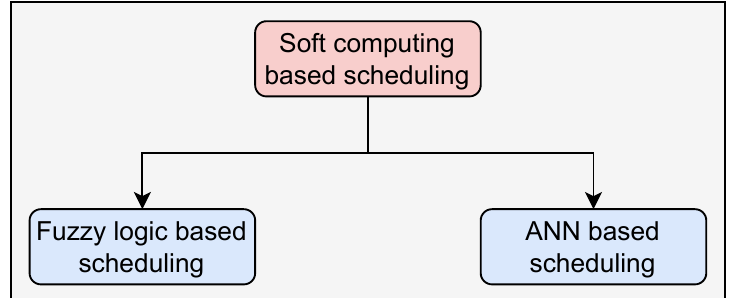
Figure 7. Soft-computing